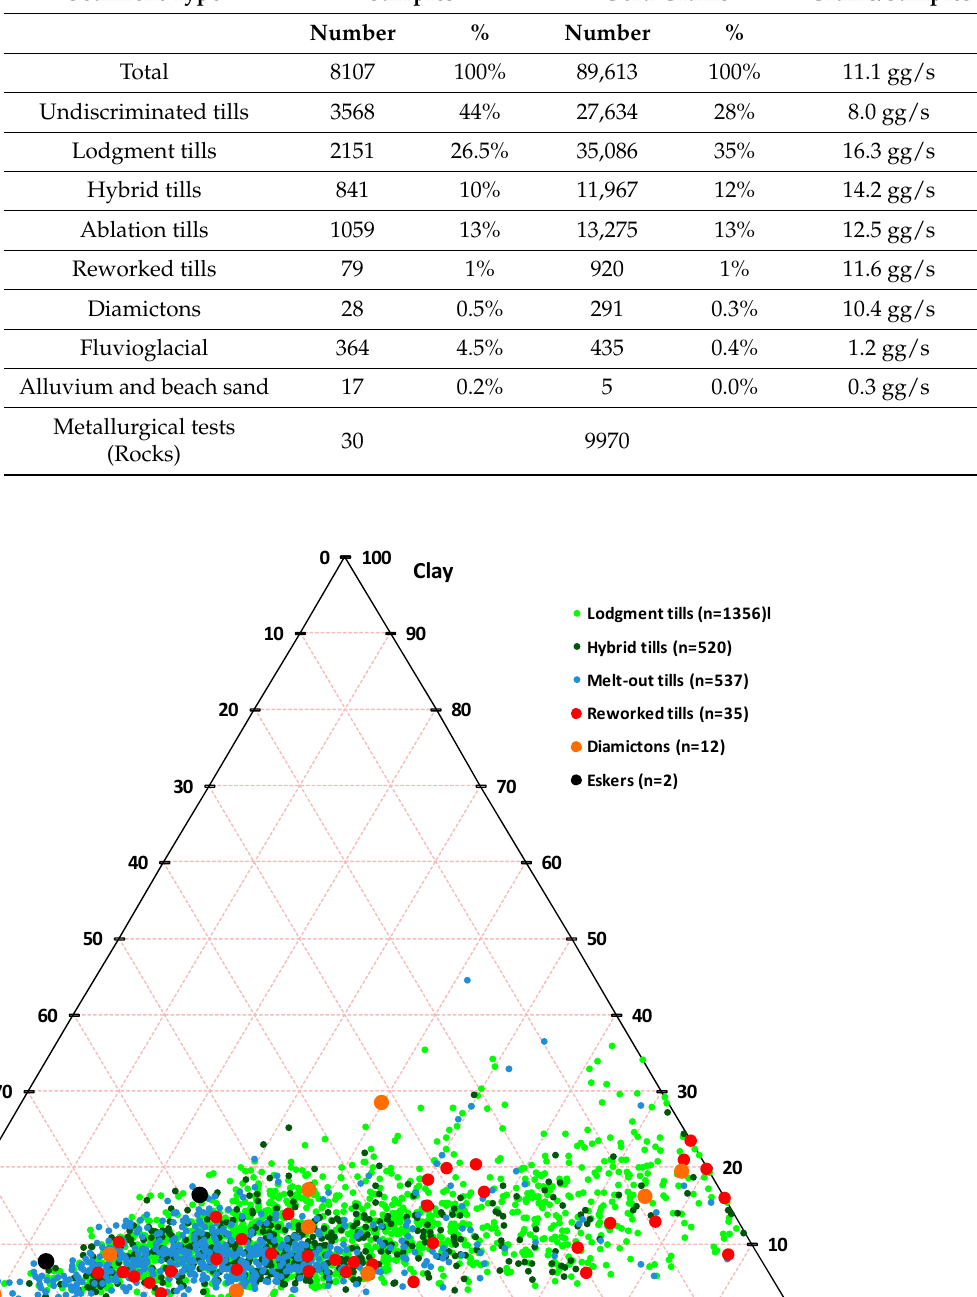
Table 2. Statistics on samples and gold grains available in the database, according to sediment types. Number of metallurgical tests and gold grains recover from these are provided for comparison.